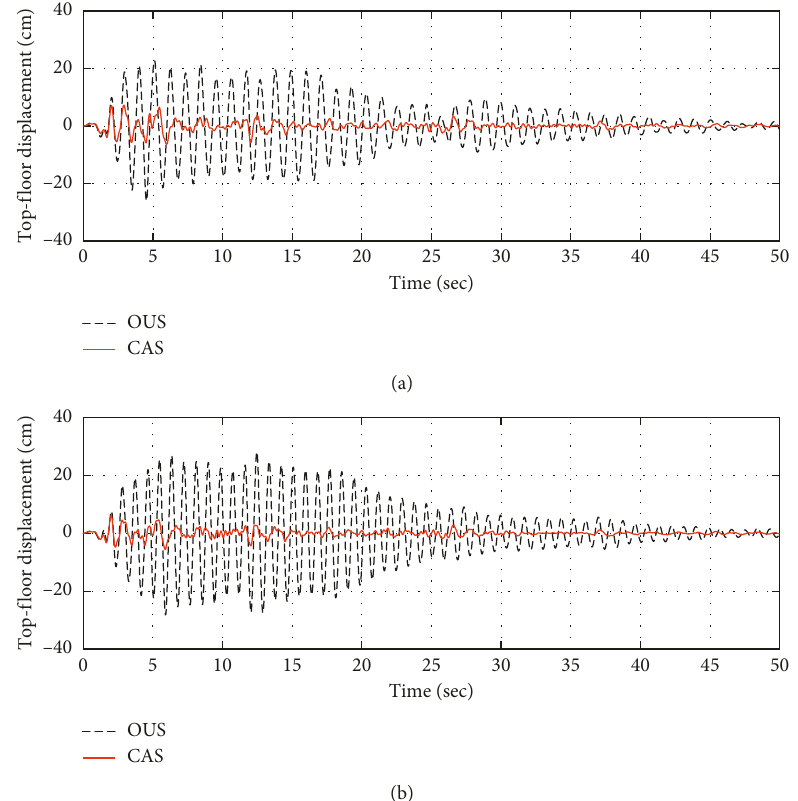
Figure 3: Comparative time-history curves of top-floor displacements between OUS and CAS against El Centro earthquakes. (a) Building 1. (b) Building